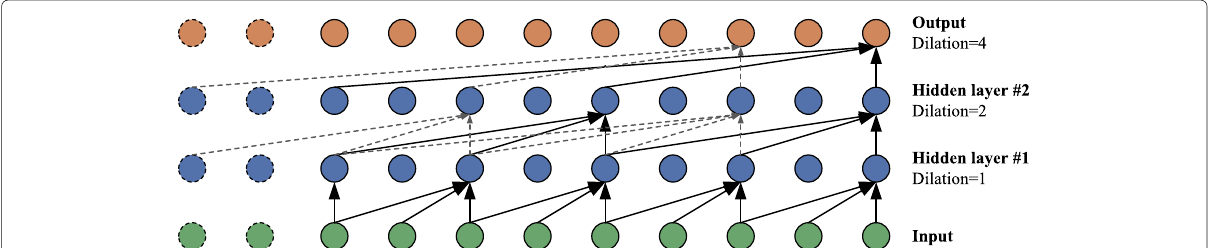
Fig. 2 A general TCN structure with causal operation. Dilation factors are equal to {1, 2, 4}, and filter size is 3. The dashed lines represent the network delayed one time